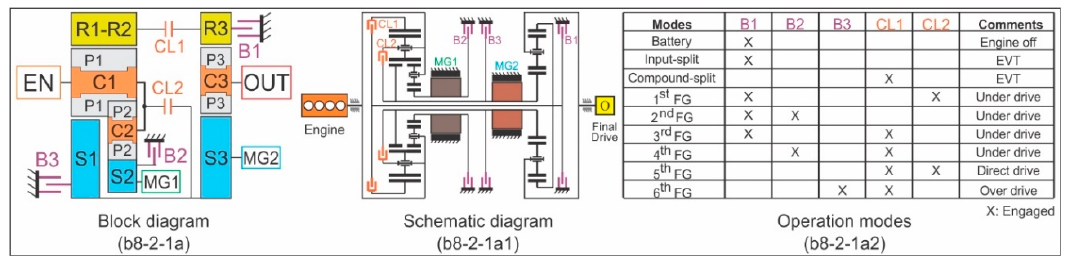
Figure 16. HT system and mode switching diagram considered in kinematic analysis.